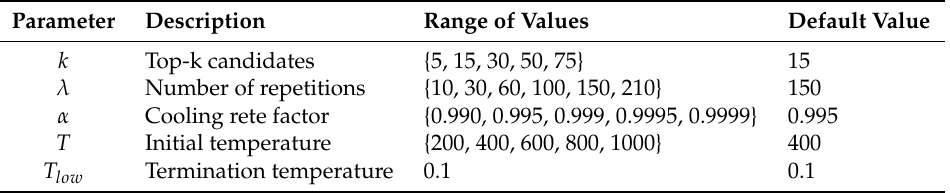
Table 5. The GRASP-AR algorithm parameters and their